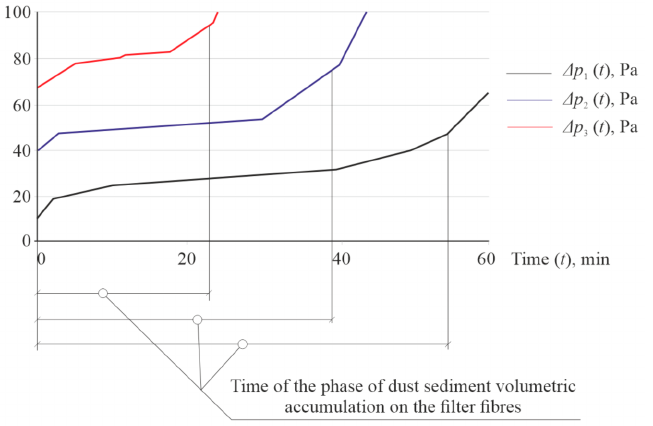
Figure 7. Curves of change in the pressure drop of the respirator with the accumulation of dust sedi- ment with a concentration in the dust chamber of 500 mg/m 3 at a constant air flow: 1—30 dm 3 /min; 2—85 dm 3 /min; 3—120 dm 3